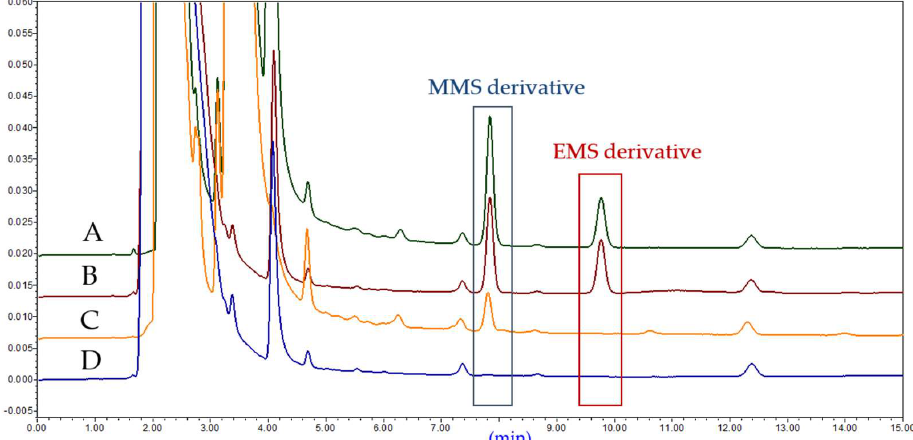
Figure 8. Typical chromatograms of the mixed 0.75 μg · mL - 1 MMS and 0.75 μg · mL - 1 EMS with BDC as the derivatization reagent. ( A ) Spiked sample; ( B ) impurity; ( C ) sample; ( D ) blank. Table 2. Summary report of the method validation.